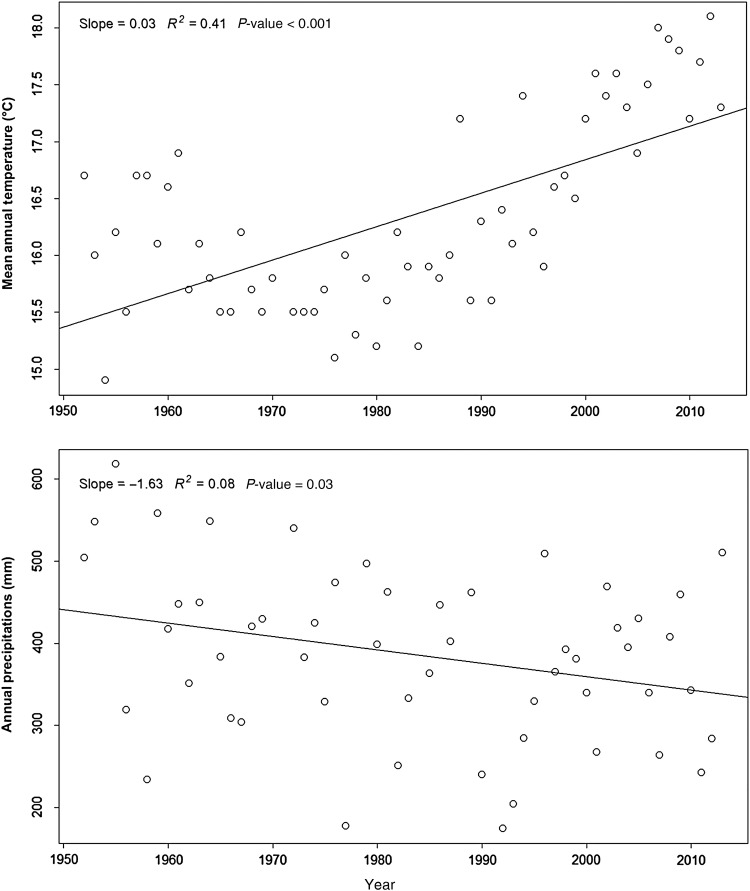
Analysis of the mean annual temperature and precipitation time series from 1950 to the present day.